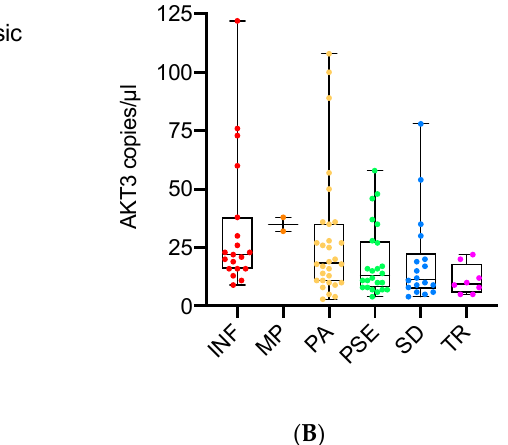
Figure 3. Association between AKT isoform expression categories and tumor morphology. ( A ) Bar chart plot showing the distribution of SET (solid, pseudo-endometrioid, transitional) and classic features among the four AKT classes; ( B ) box plots representing AKT3 expression among the six HGSOC growth patterns. INF—infiltrative; MP—micropapillary; PA—papillary; PSE—pseudo-en- dometrioid; SD—solid; TR—transitional-like.